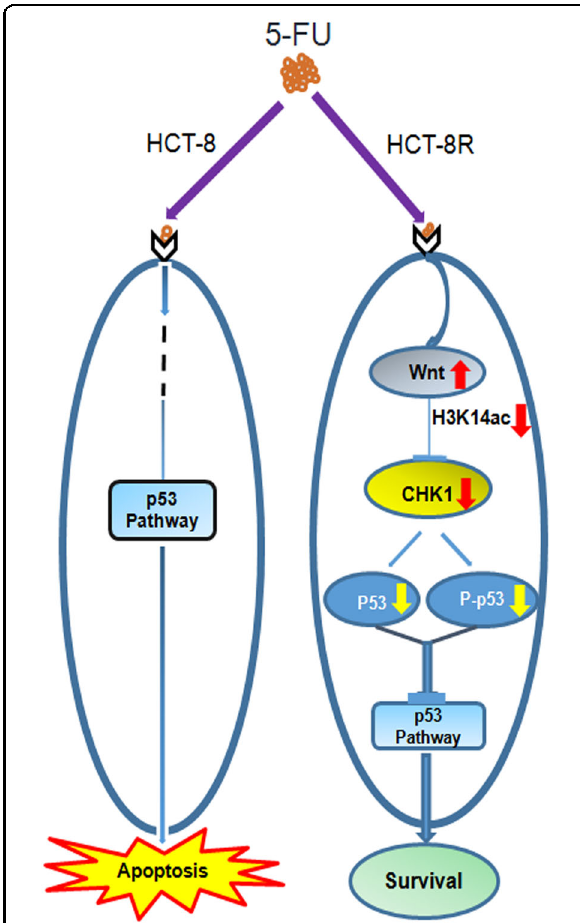
Fig. 7 A schematic representation of HCT-8R cell resistance to 5- FU. A schematic representation showing that the p53 pathway is normal and responsive to proapoptotic reagents such as 5-FU in HCT- 8 cells, but in 5-FU-resistant colorectal cancer cells (HCT-8R) with a wild-type p53 pathway, the Wnt pathway suppresses CHK1-induced cell cycle arrest and apoptosis through inhibition of the CHK1 pathway, which phosphorylates and stabilizes p53. H3K14ac modi fi cation plays a critical role in the Wnt-mediated regulation of drug